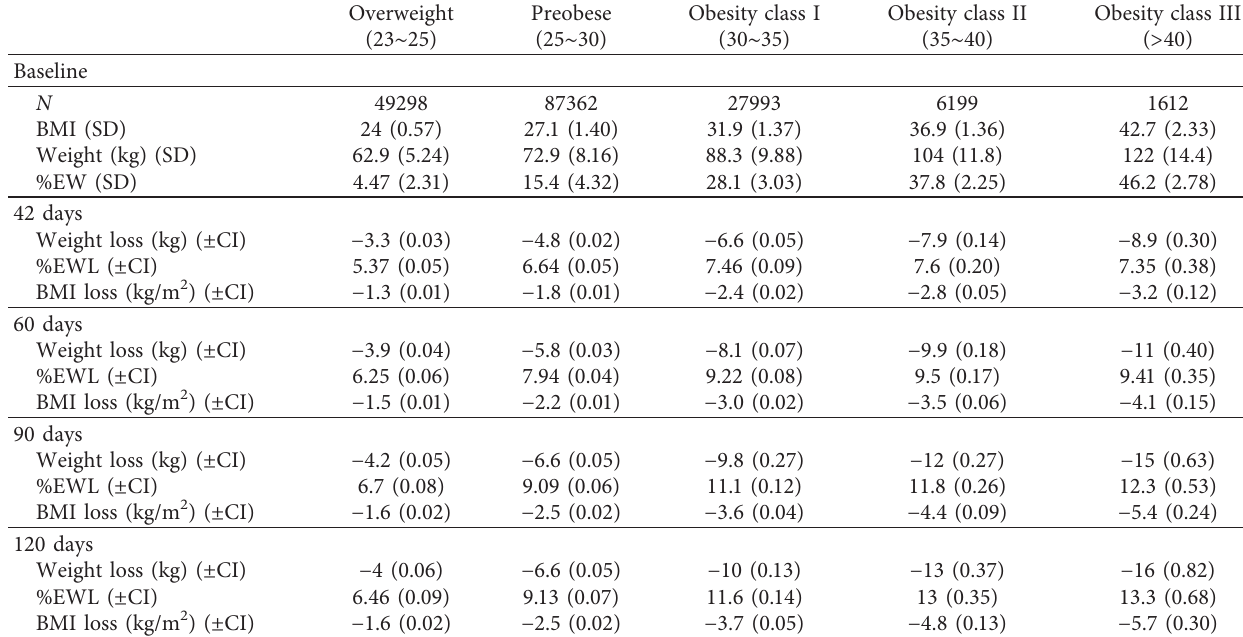
Table 3: Weight loss results for users with BMI ≥ 23.0kg/m 2